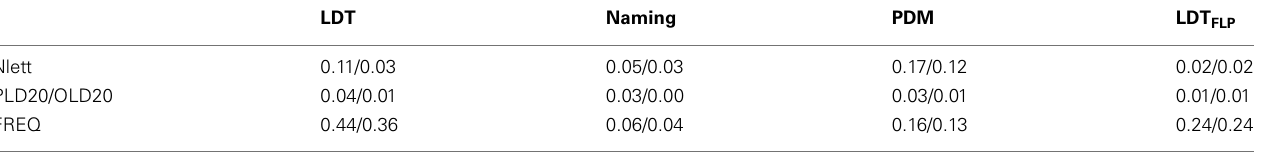
Table 4 | Percentages variance explained (differences of 0.01 are significant at the p < 0.05 level).